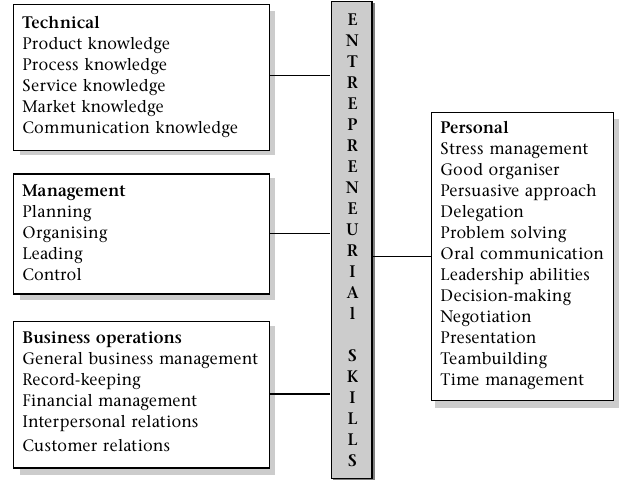
Figure 1:Categories of micro entrepreneurial skills empirically